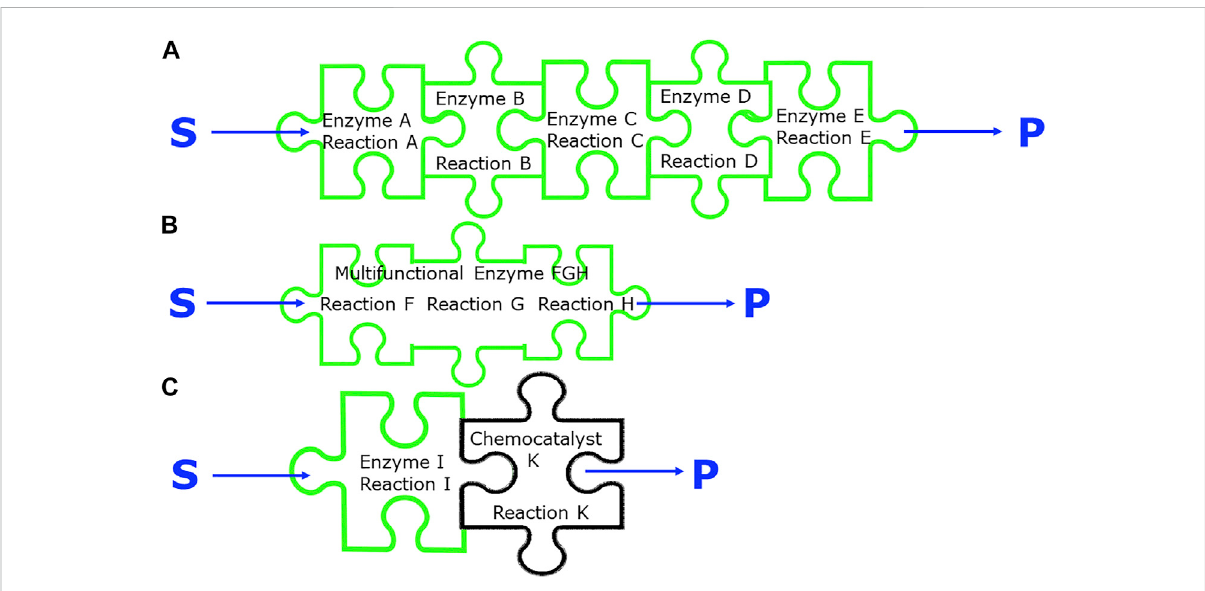
FIGURE 5 Different integration strategies of biocatalytic processes, (A) use of fi vedifferentenzymes. ina sequential reaction cascade orsimultaneously in a one-pot reaction, (B) use of one multifunctional enzyme catalyzing three related reactions, (C) use of a biocatalytic and a chemocatalytic reaction in a sequential reaction or in a one-pot